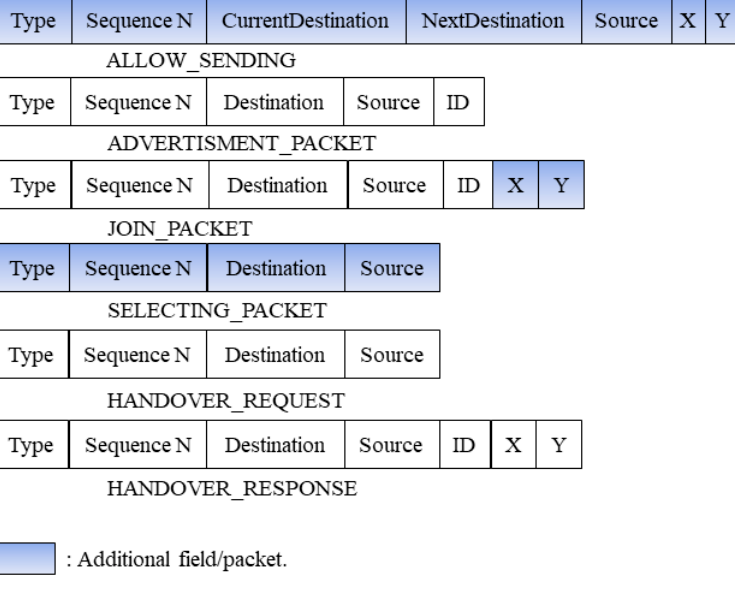
Figure 4. The di ff erent Packets used in Figure 4. The different Packets used in CLR-MSPH.